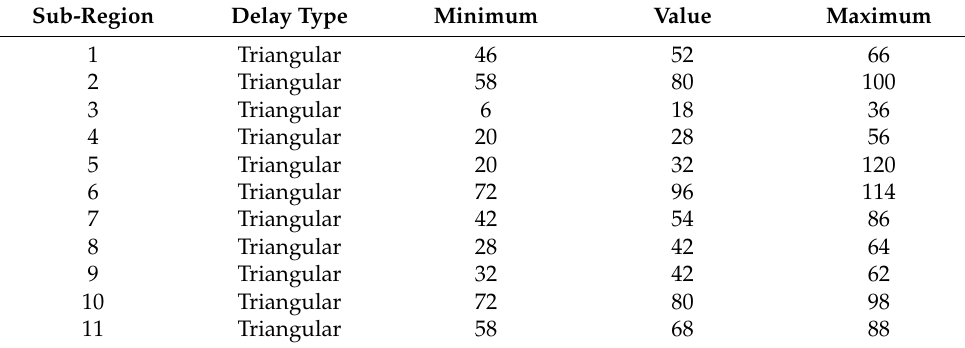
Table 6. Parameter setting of vehicle’s task execution time.